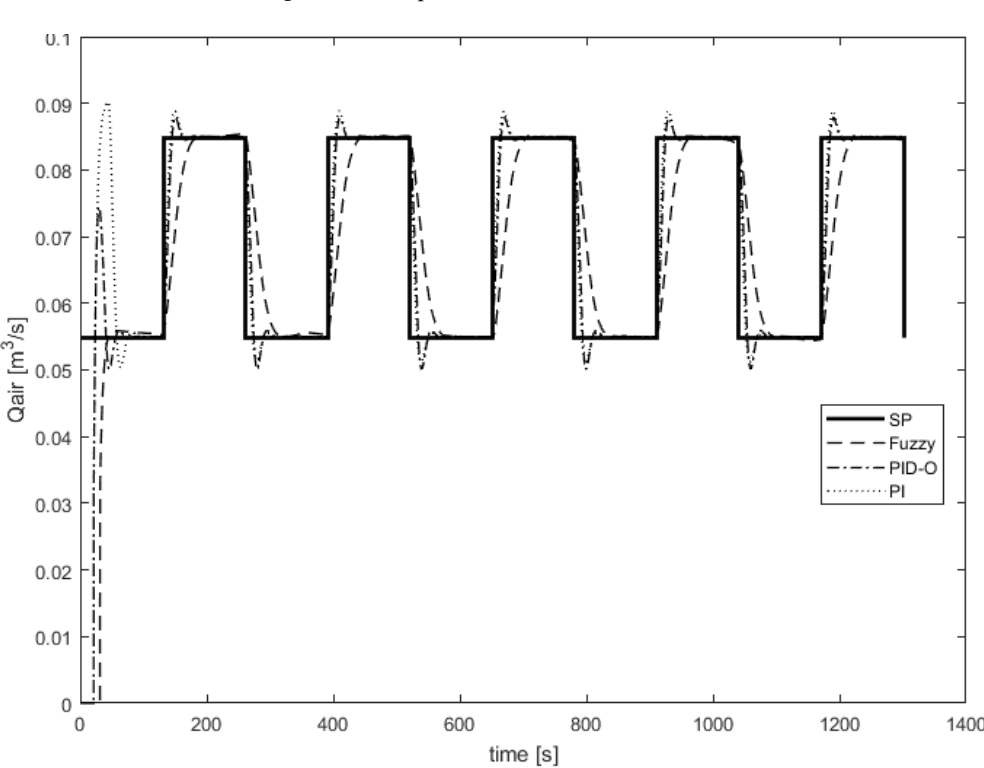
Energies 2020 , 13 , x FOR PEER REVIEW Figure 14. Comparison of control methods— n . Figure 14. Comparison of control methods— n .